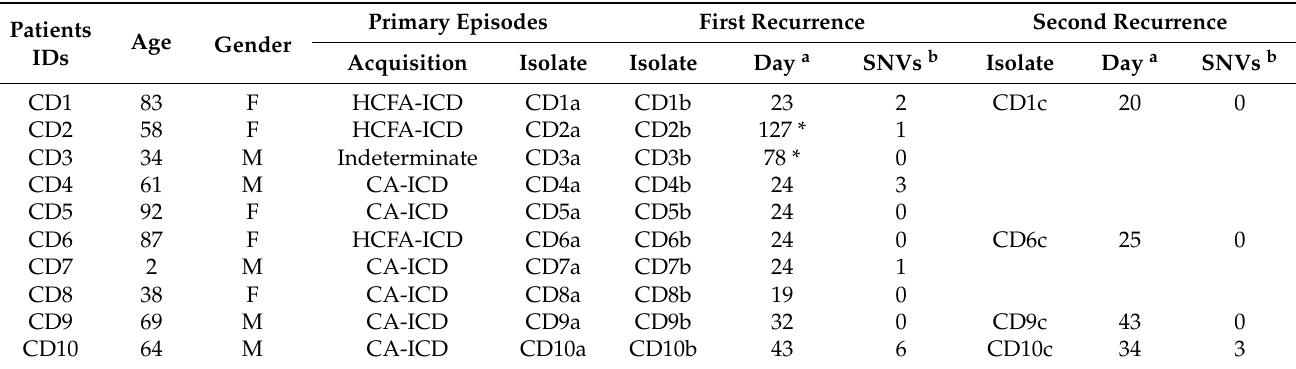
Table 1. Epidemiological data of patients and isolates including type of CDI acquisition, time elapsed between episodes, and pairwise single-nucleotide variant (SNV)